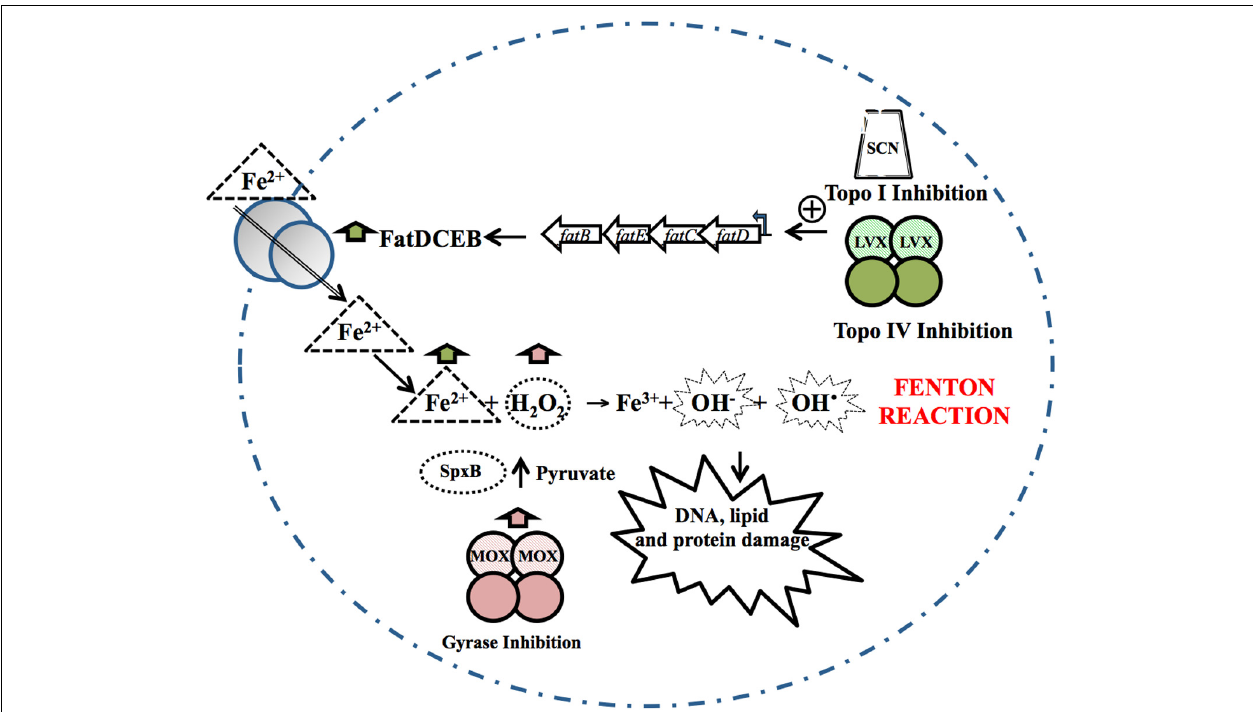
FIGURE 2 | Oxidative damage cell death pathway. The inhibition of Topo IV by LVX, or of Topo I by SCN, causes a local increase in supercoiling, resulting in the up-regulation of the fatDCEB operon. The consequent increase in the iron transporter it encodes causes an increase in intracellular Fe 2 + . MOX alters the transcriptome, up-regulating genes from several metabolic pathways involved in the production of pyruvate. Pyruvate can then be converted by pyruvate oxidase (SpxB) into hydrogen peroxide (H 2 O 2 ). Fe 2 + and H 2 O 2 are the substrates of the Fenton reaction. The Fenton reaction renders hydroxyl radicals, which oxidatively damage DNA, proteins and lipids. Taken from Ferrándiz and de la Campa (2014), with